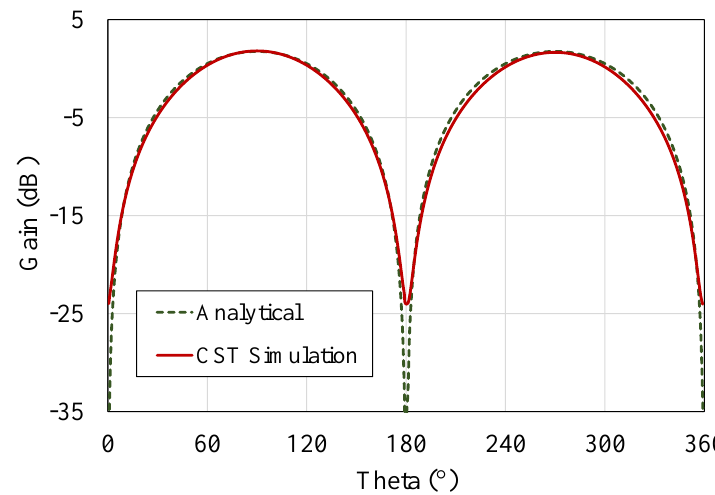
Figure 11. Analytically calculated and numerically simulated (CST) gain pattern of the antenna showing a close agreement and a 1.81 dBi gain.